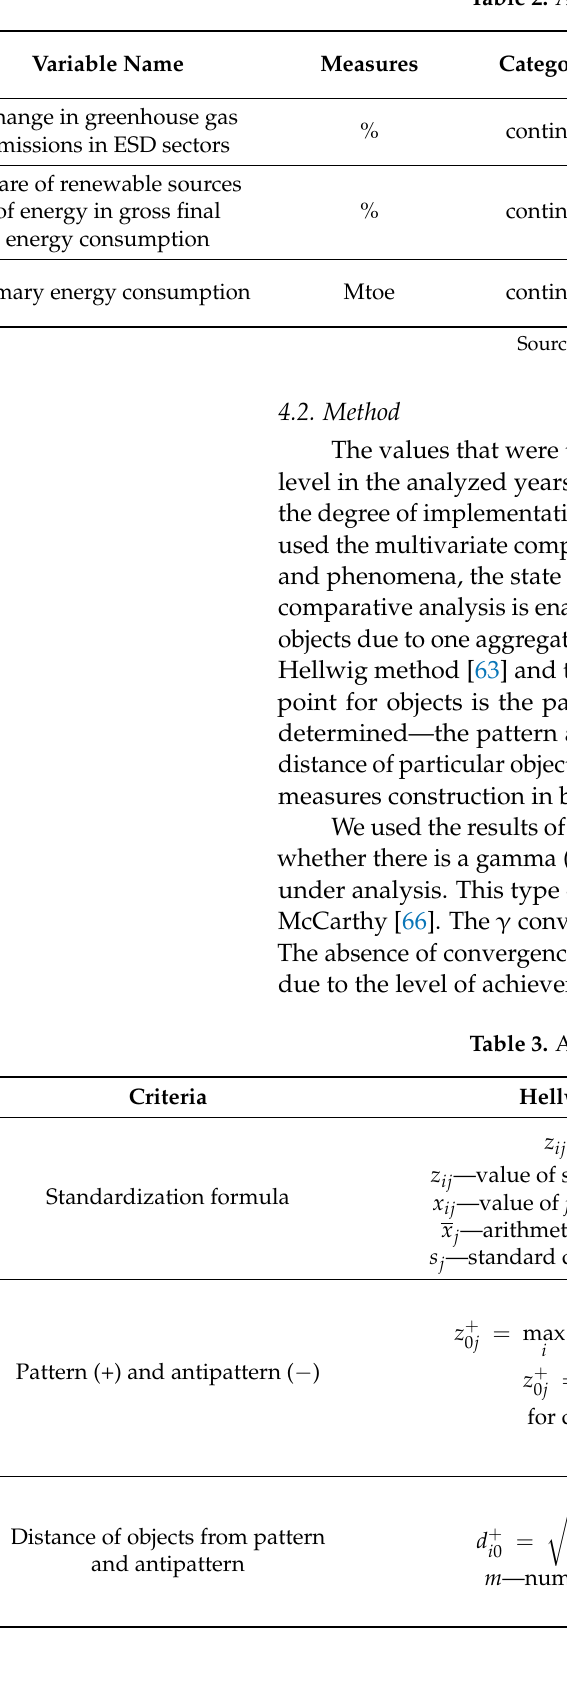
Table 2. Applied variables.